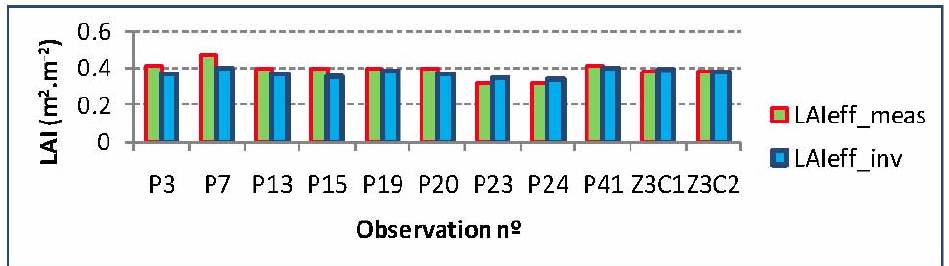
Figure 18. Effective LAI, measured vs. inverted